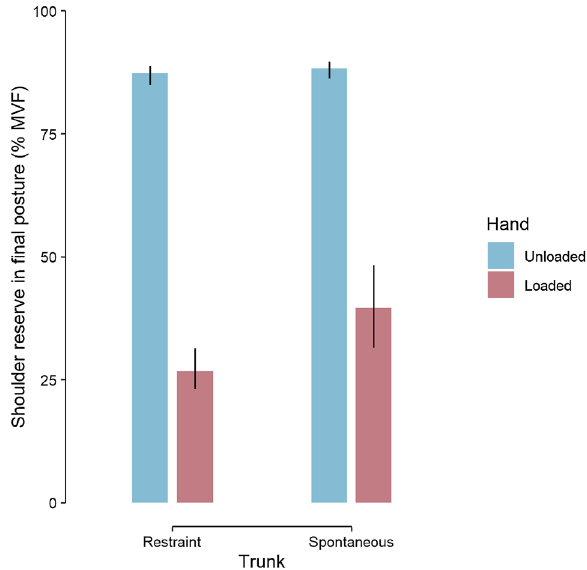
Figure 4. Shoulder reserve in final posture as a function of trunk restraint and hand load. Shoulder reserve is in percentage of maximal antigravity shoulder torque. In each barplot, the top of the bar represents the median, error bar extends from the first to the third quartile. All comparisons are statistically significant. The figure shows that shoulder reserve stays high in the unloaded conditions. When the hand is loaded and the trunk is restrained, shoulder reserve is considerably